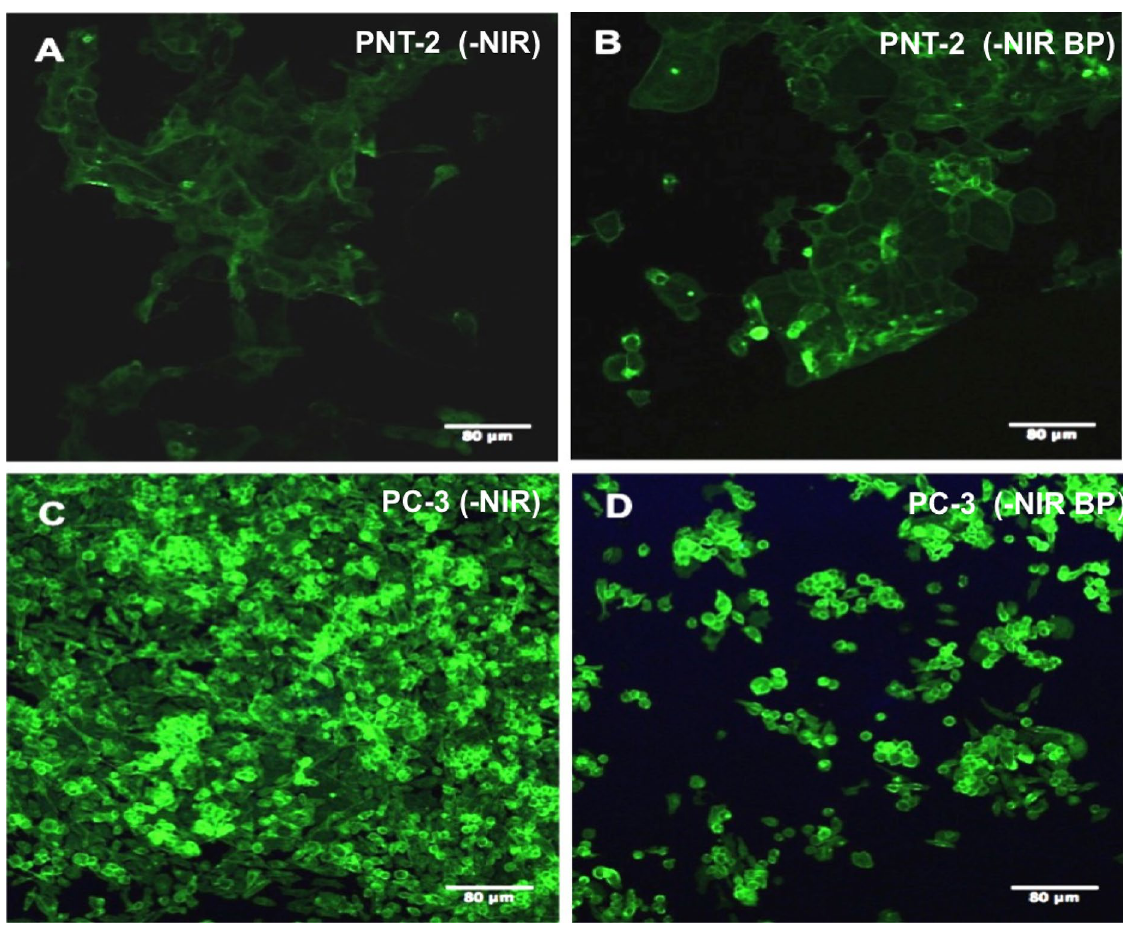
Figure 3. Effect of not irradiated (-NIR) 2D BP on PNT-2 and PC-3 cell density (qualitative analysis). PNT-2 and PC-3 cells grown in absence ( A , C ) and in presence ( B , D ) of 2D BP. The exposure of PNT-2 cells to 2D BP does not change cell density ( B ) compared to control ( A ). By contrasts, 24 h of 2D BP treatment reduces PC-3 density ( C ) compared to cells in the control ( D ). The images are representative of three experiments. Cell morphological features at 72 h 2D BP treatment are reported in Fig. S2 of Supporting information